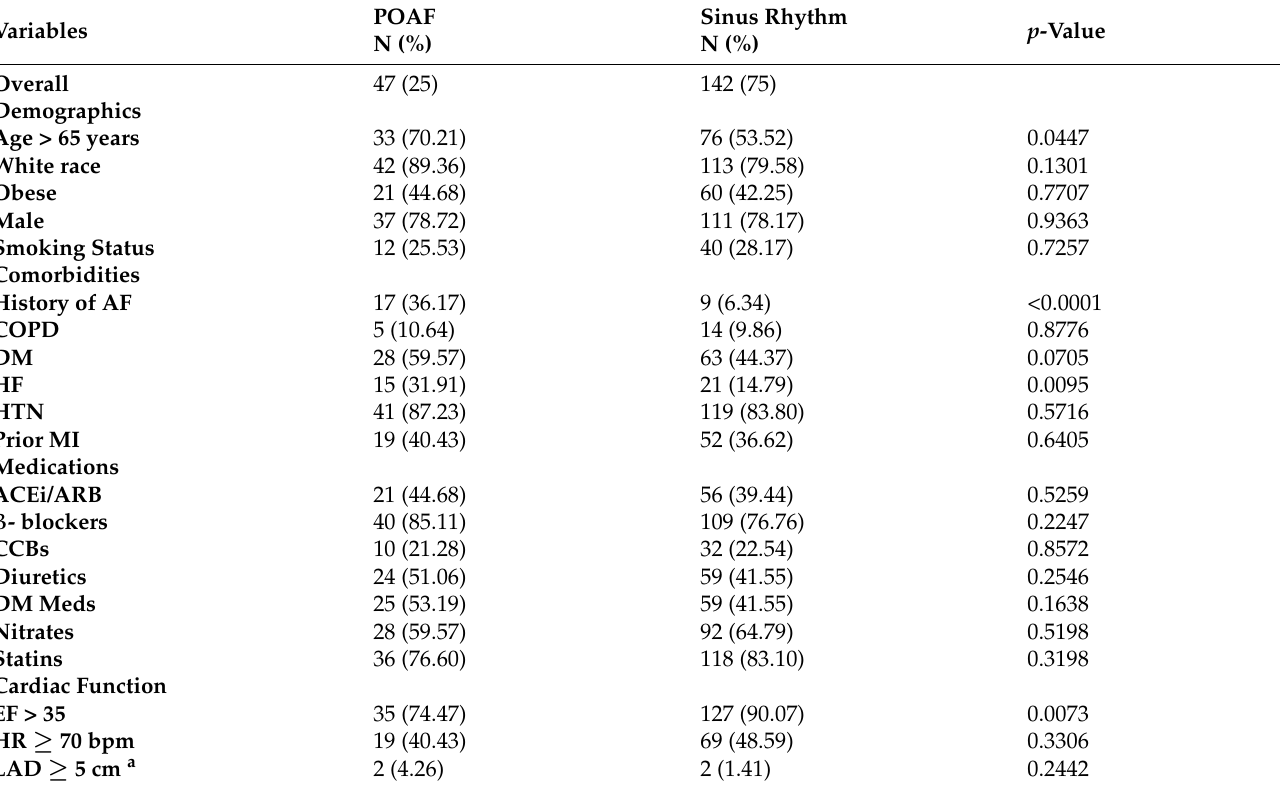
Table 1. Patient clinical and demographic